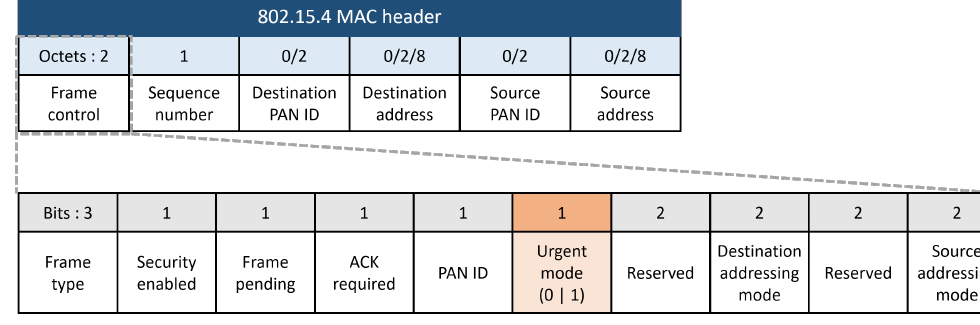
Figure 8. Urgent mode flag bit in a MAC header.